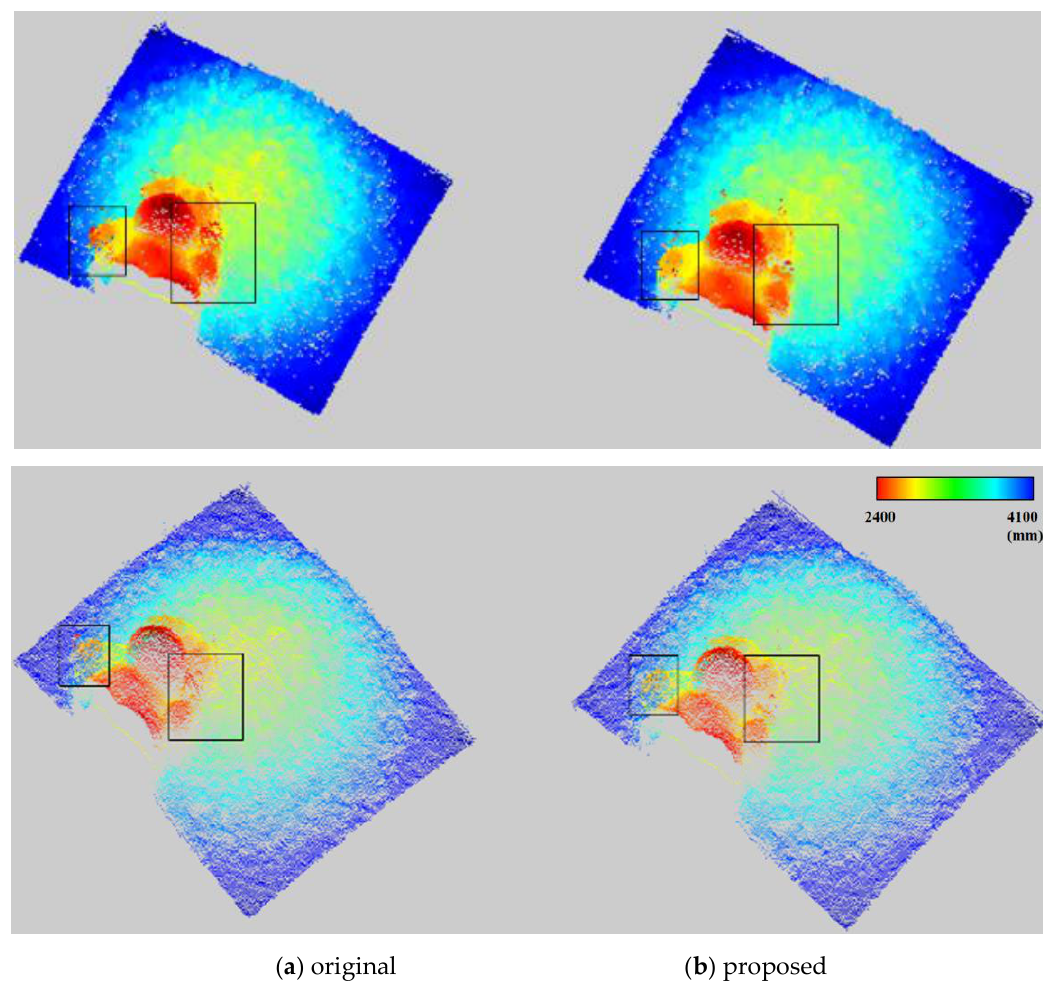
Figure 15. Three-dimensional point cloud.